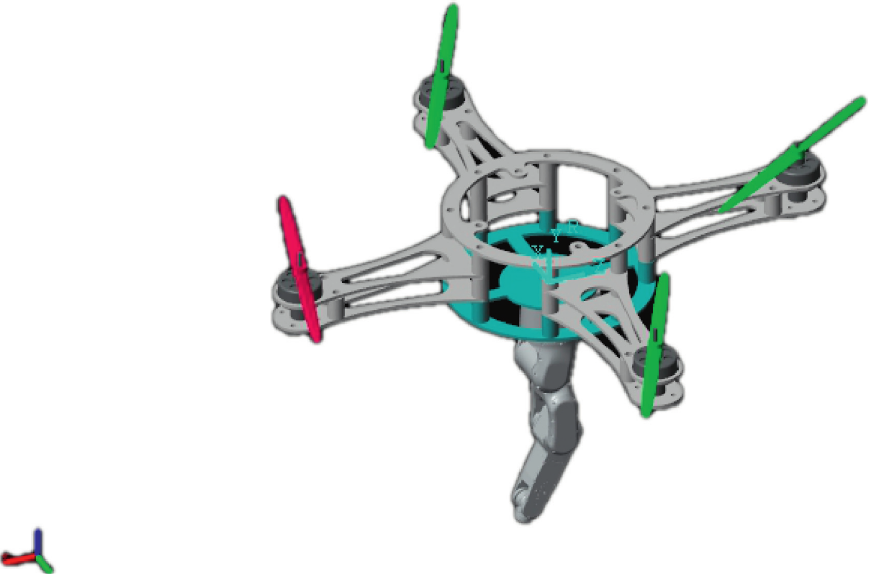
Figure 3: A simple model of aerial